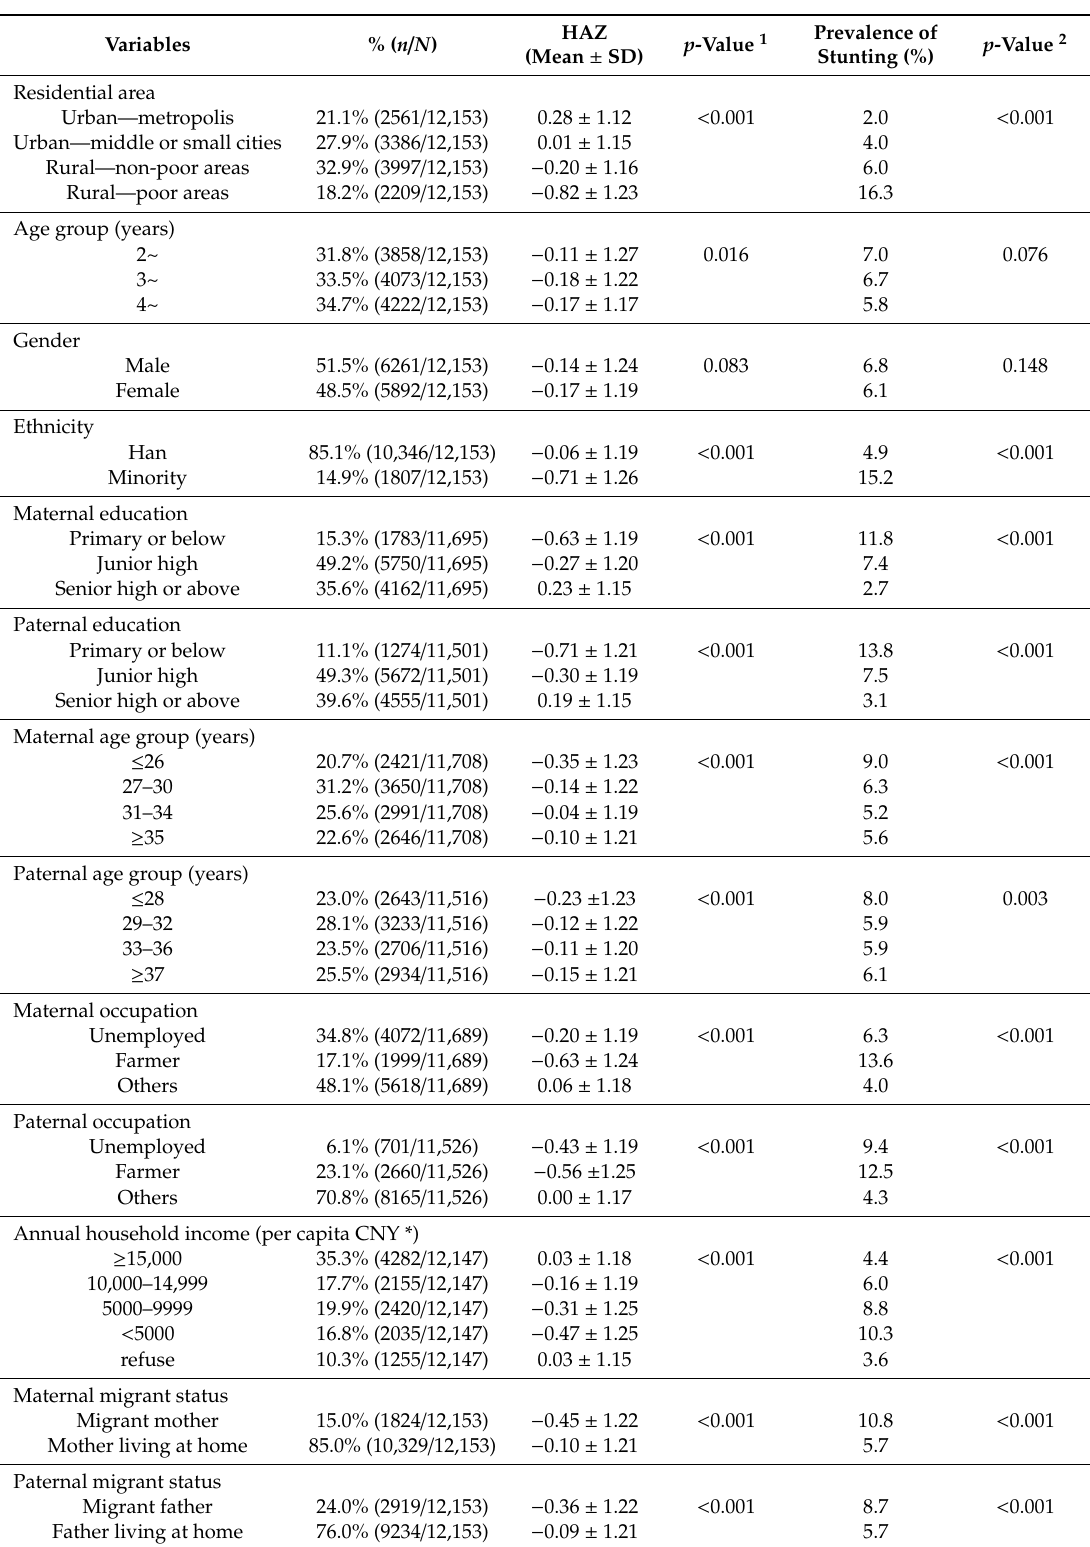
Table 1. The relationship between socioeconomic status and height-for-age Z-score (HAZ) and the prevalence of